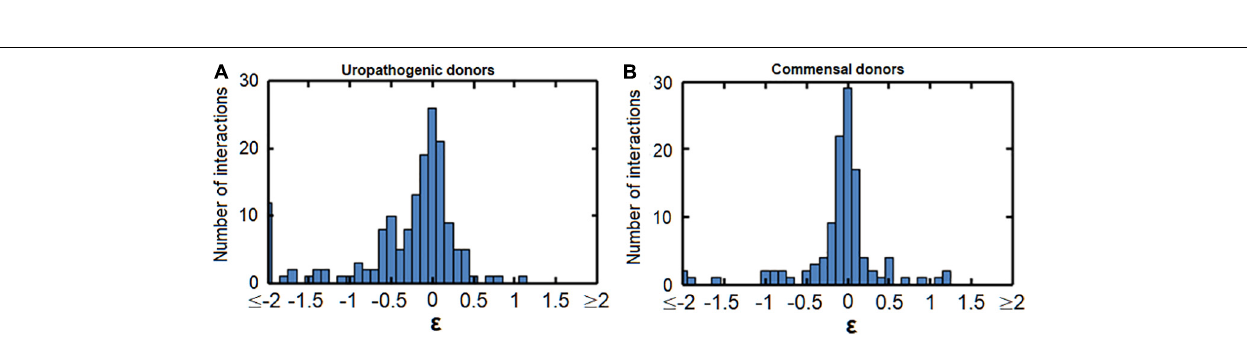
FIGURE 5 | Histograms of the interactions between commensals and uropathogens. (A) The effect of uropathogenic donors on the population size of commensal acceptors. (B) The effect of commensal donors on the population size of uropathogenic acceptors. Commensal acceptors exhibited a more negative response ( < ε = log(0.6) = –0.51) to uropathogens than uropathogens to commensals. A similar pattern was observed for interactions affecting the doubling time and the length of the lag phase ( Supplementary Figure 5 ).